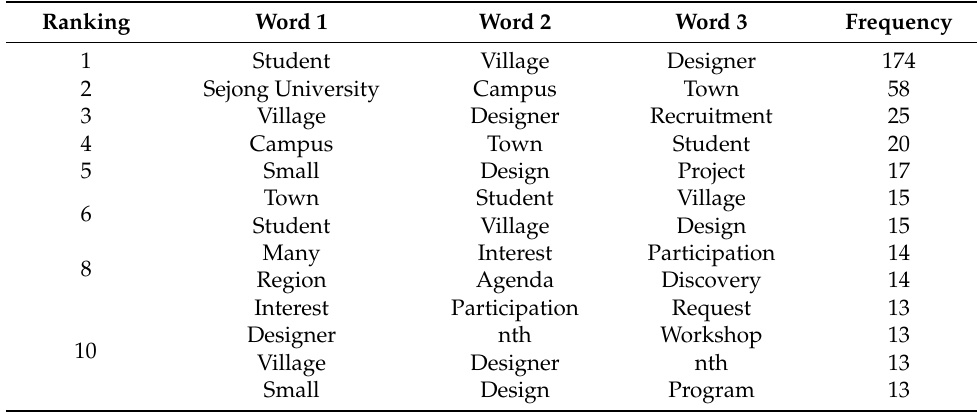
Table 4. Phrases of 3-g appearing simultaneously (total). Table 2. Frequency of words (nouns) mentioned by each participant. Table 2. Frequency of words (nouns) mentioned by each